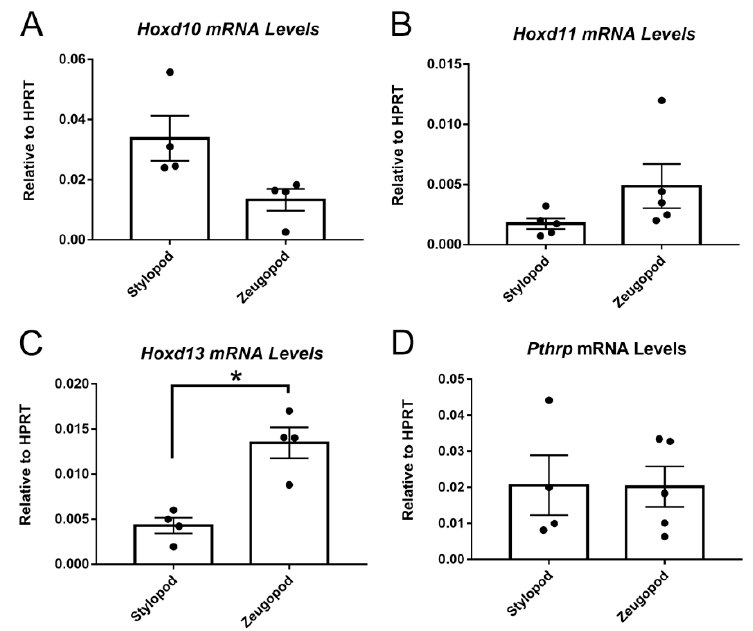
Figure 2. E18.5 stylopod and zeugopod eSZ cells express distinct Hox profiles. ( A ) Hoxd10 mRNA levels relative to hypoxanthine guanine phosphoribosyltransferase (HPRT) in freshly isolated stylopod and zeugopod eSZs. ( B ) Hoxd11 mRNA levels relative to HPRT in freshly isolated stylopod and zeugopod eSZs. ( C ) Hoxd13 mRNA levels relative to HPRT in freshly isolated stylopod and zeugopod eSZs. ( D ) Pthrp mRNA levels relative to HPRT in freshly isolated stylopod and zeugopod eSZs. * p ≤ 0.05. Error bars are SEM.